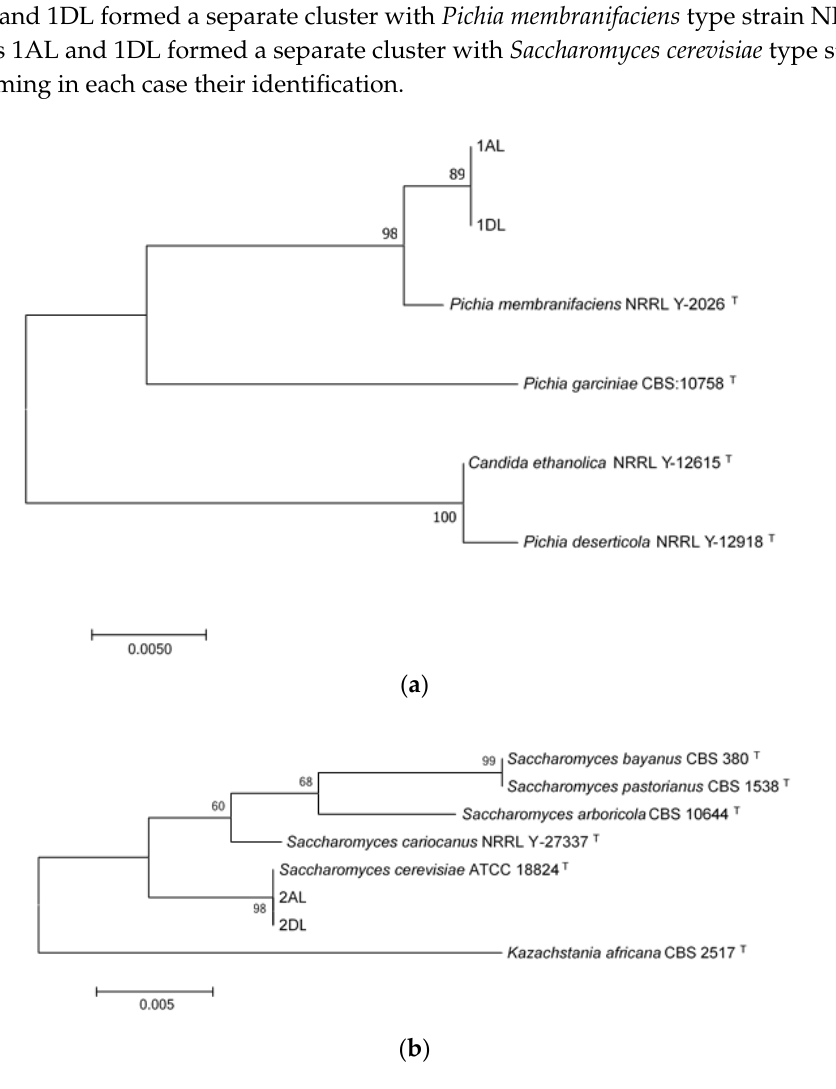
Figure 5. Phylogenetic trees based on D1/D2 sequences from ( a ) Pichia membranifaciens . ( b ) Saccharomyces cerevisiae isolates. Trees were constructed using the neighbor-joining method. Bootstrap values (1000 tree interactions) are indicated at the nodes. T- means type strain.